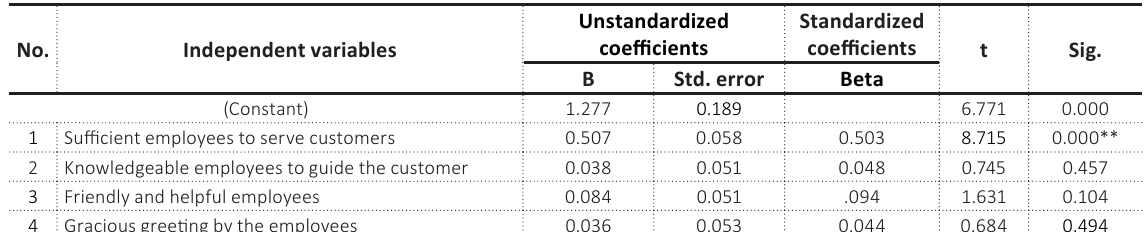
Table 19. Regression analysis of the impact of store employees’ interaction on customers’ impulse buying behavior